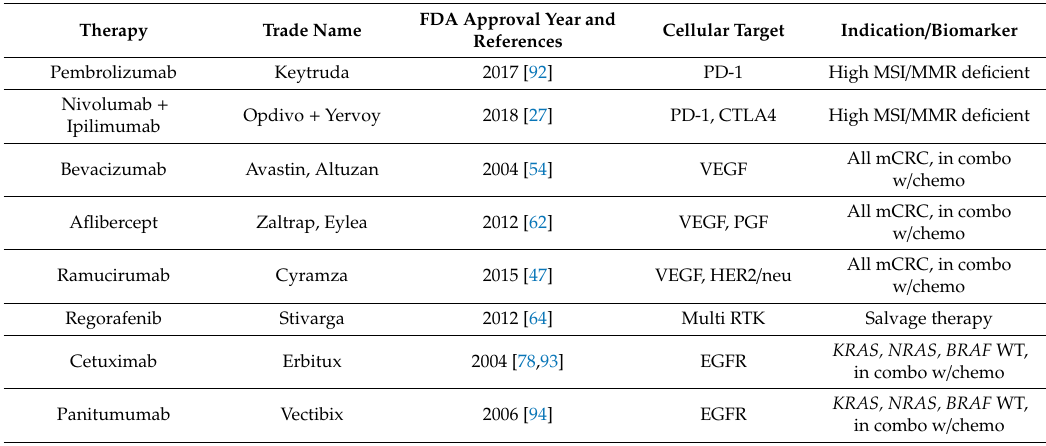
Table 1. Approved therapies and associated biomarkers in colorectal